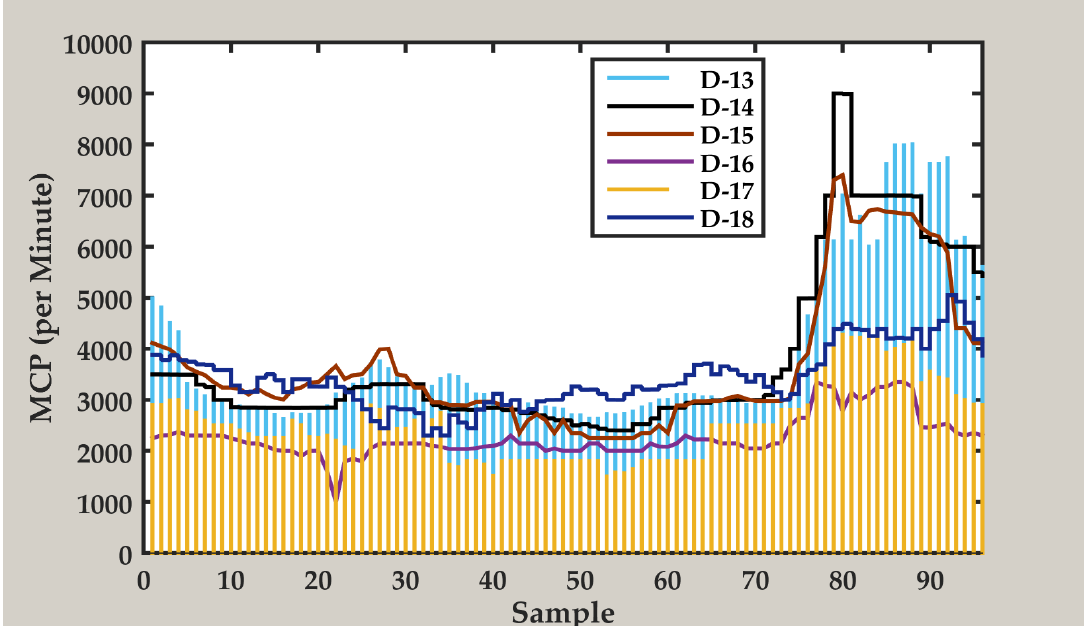
Figure 3. Data samples for evaluation of the performance of proposed cubic grey model